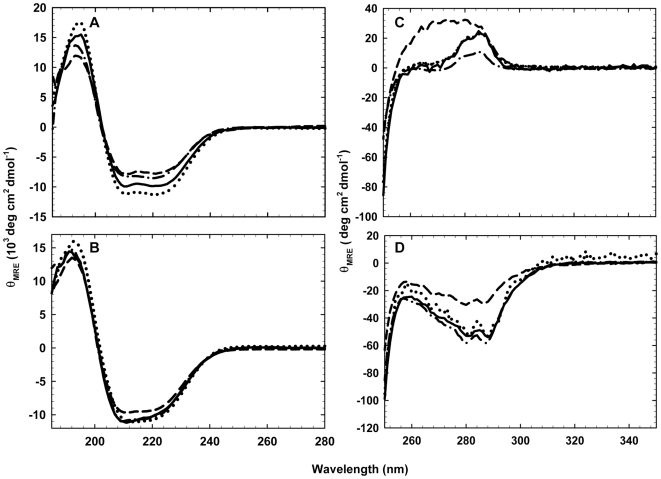
Ellipticity of wild-type and clamp-deletion variants of sIGPS and eIGPS.Far-UV (a, b) and near-UV (c, d) CD spectra of sIGPS (a) and (c): sIGPS-WT (–––––), sIGPS-Δβ2α2-E74A (– • –), sIGPS-Δβ3α3-D128A (•••), and sIGPS-Δβ7α7-N228A (– –); and eIGPS (b) and (d): eIGPS-WT (–––––), eIGPS-Δβ1α1-S82A (– • –), eIGPS-Δβ3α3-D132A (•••), and eIGPS-Δβ7α7-N231A (– –). Buffer conditions: 10 mM potassium phosphate, 0.2 mM K2EDTA, 1 mM βME, pH 7.8 for sIPGS and pH 7.0 for eIGPS at 25°C.